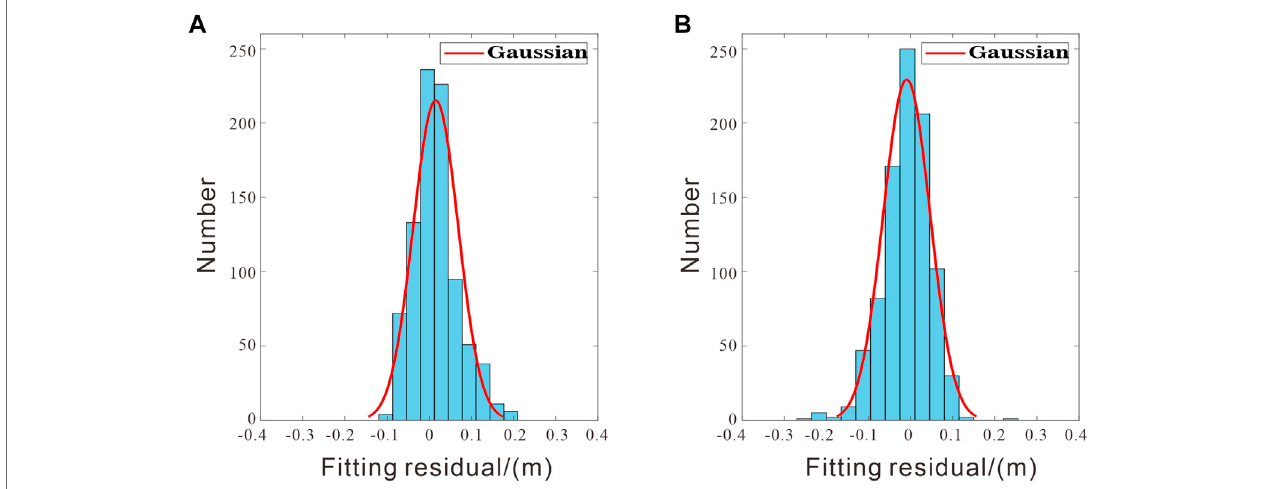
FIGURE 8 | Histograms of the fi tting residuals. (A,B) represent the fi tting residual histograms of the inversion results of the T128 ascending orbit and the T33 descending orbit. The red solid line indicates the Gaussian distribution curve fi tted by the distribution.